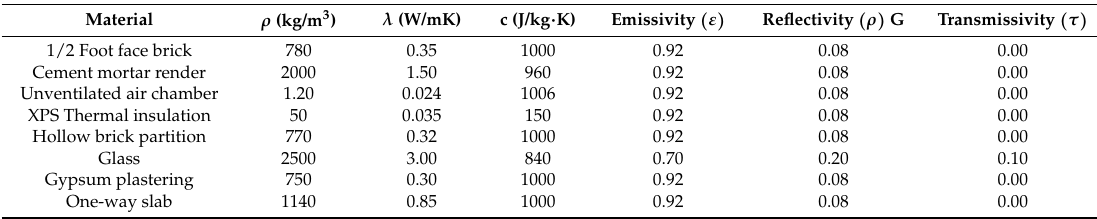
Table 2. Building materials properties.